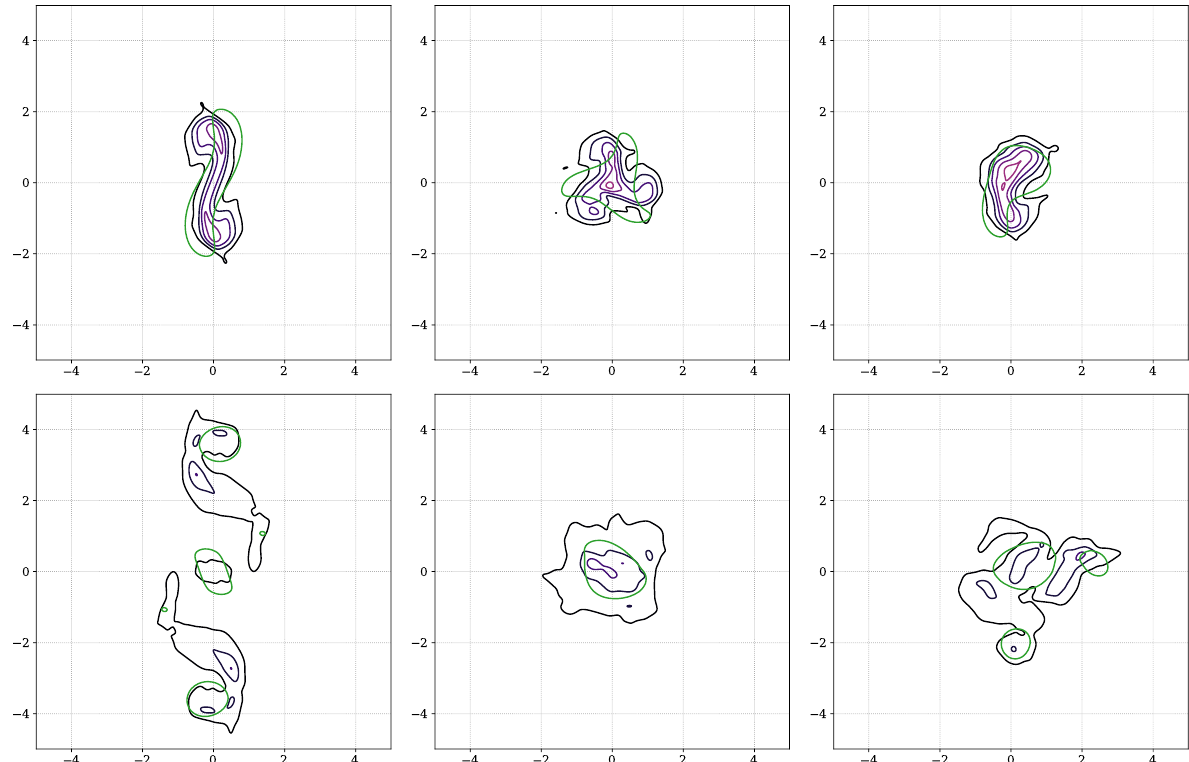
Figure 9. Evolution of the lower-layer PV at t = 130 f − 1 ( upper row ) and t = 260 f − 1 ( lower row ), for the eddy with Q 1 = 12 and δ = 0.20 initialised with azimuthal mode number m = 2 ( left column ), m = 3 ( middle column ) or several wavenumbers ( right column ); corresponding to the pressure and layer thickness shown in Figure 8 (panels are transposed). The nondimensional lower-layer PV anomaly is contoured every 0.15 from black to purple, starting at 0.05. The green contour indicates upper layer thickness at value 0.05 = δ H 0